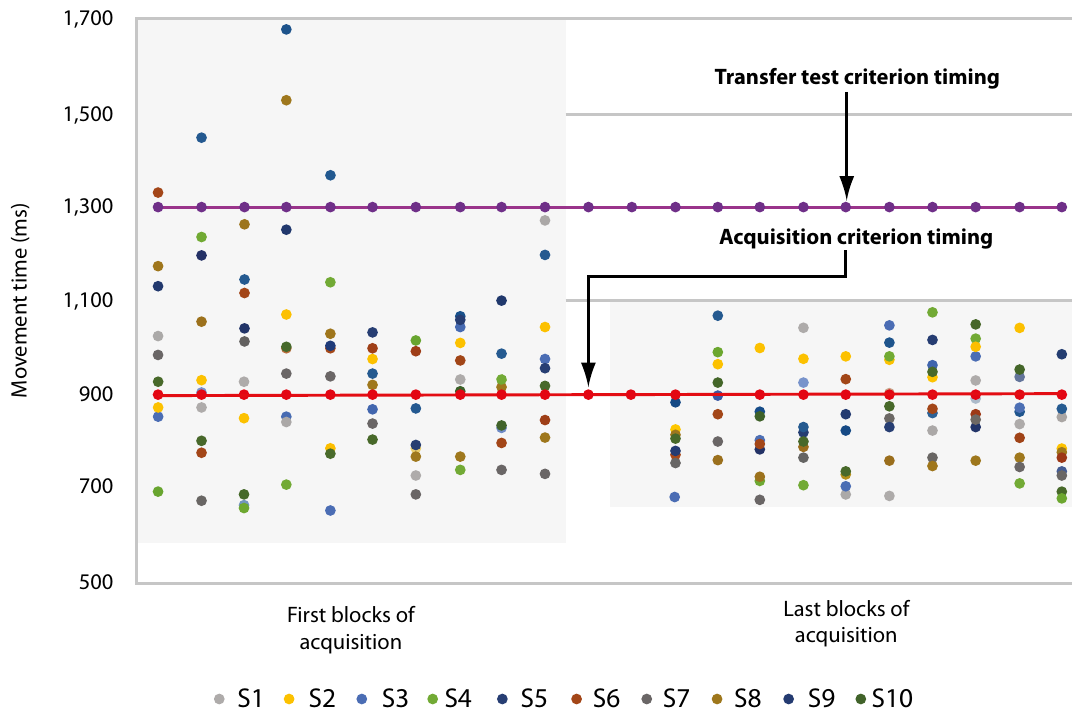
Figure 4. Motor response dispersion in the first and the last block of acquisition during the random practice.